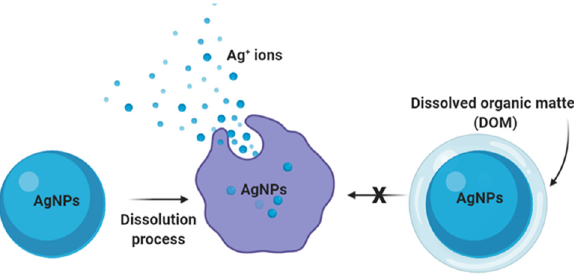
Figure 4: The e ff ect of DOM on AgNPs ’